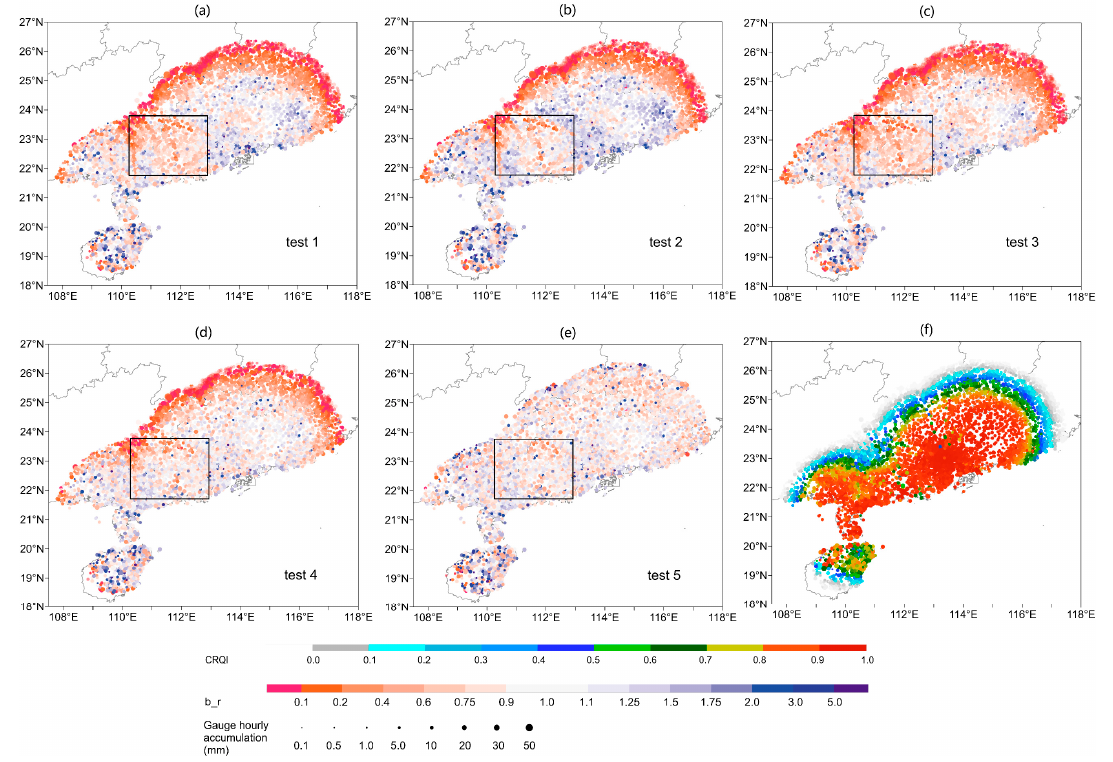
Figure 4. B_r distributions of the mosaic QPE in tests ( a ) 1, ( b ) 2, ( c ) 3, ( d ) 4, and ( e ) 5. The b_r was calculated between the QPE and observed precipitation at a given RG station. The evaluation results were based on all nine of the rainfall events. The bubble indicates the b_r at an RG station. Different colors indicate different b_r values. Red indicates underestimation, and purple indicates overestimation. ( f ) Average CRQI distribution for the nine rainfall events. The colors of the bubbles indicate the average CRQI values at the RG stations. The bubble size indicates the average hourly accumulated rainfall at each RG station.